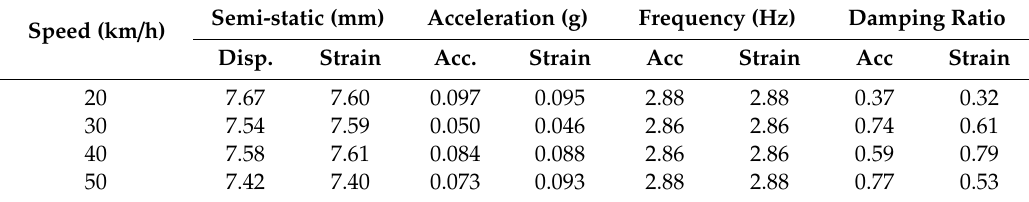
Table 3. Time and frequency domain evaluation for the bridge response. Speed (km /